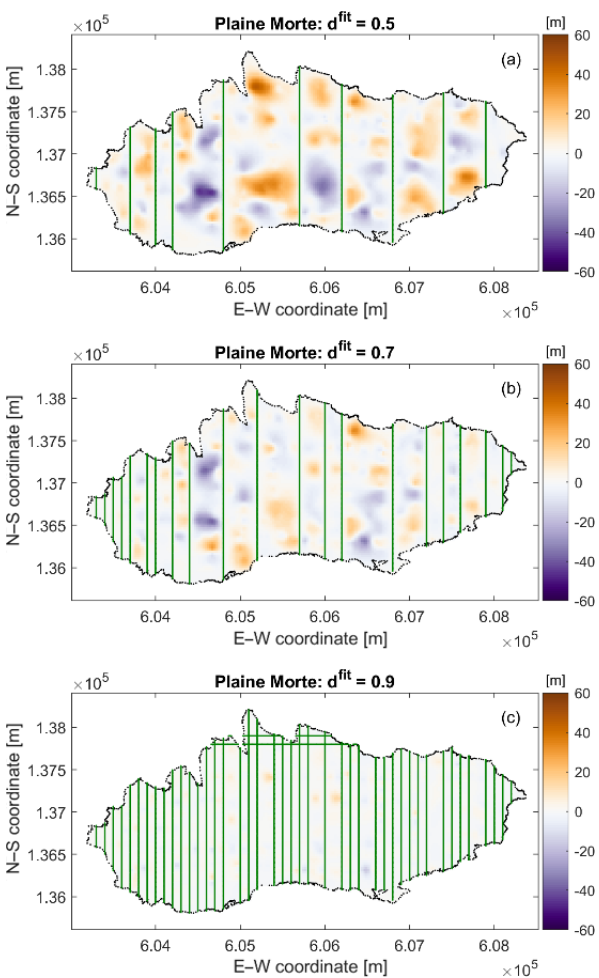
Figure 10. Glacier de la Plaine Morte model misfit h true − h est k af- ter selected stages of the experimental design procedure using syn- thetic data (see also vertical dashed lines in Fig. 5). The selected GPR profiles are superimposed with green